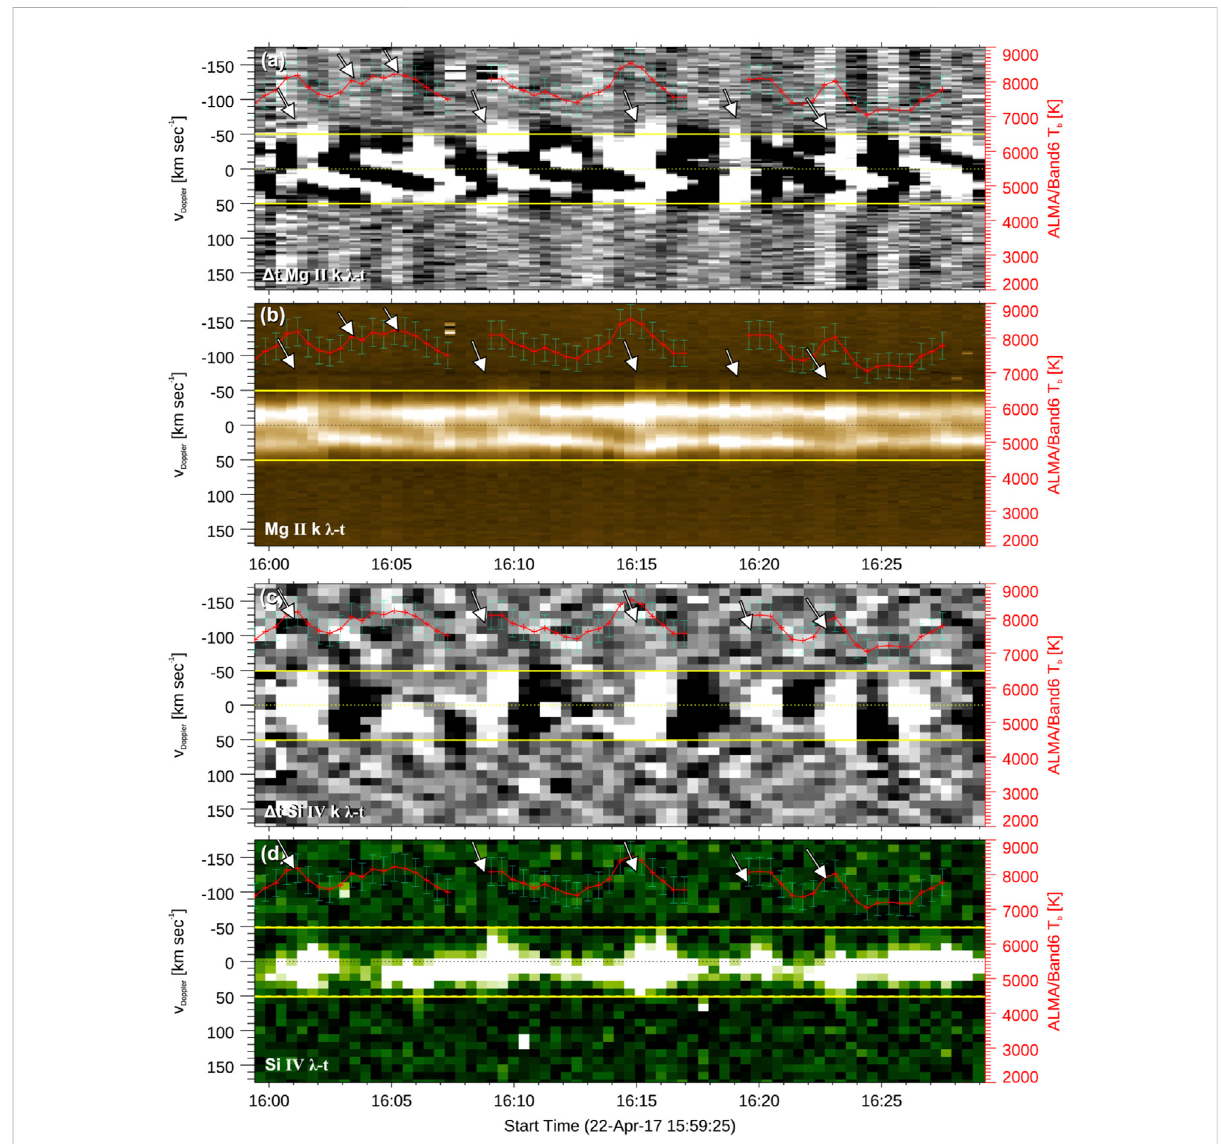
FIGURE 11 Signaturesofrecurrentshocksintheselected1 ″ ×1 ″ areainplageintheformofthewavelength – tplotsfor (B) MgIIkand (A) itstimederivative, (D) Si IV and (C) its time derivative. ALMA Band 6 brightness temperature is overplotted in red in all panels. The rest-wavelength position is plotted with a dotted line in all panels. The increases in mm brightness correlate with blueshifts, suggesting chromospheric heating due to the passing of shocks in Si IV and Mg II (indicated by arrows). From Chintzoglou et al. (2021a). Reproduced by permission of the